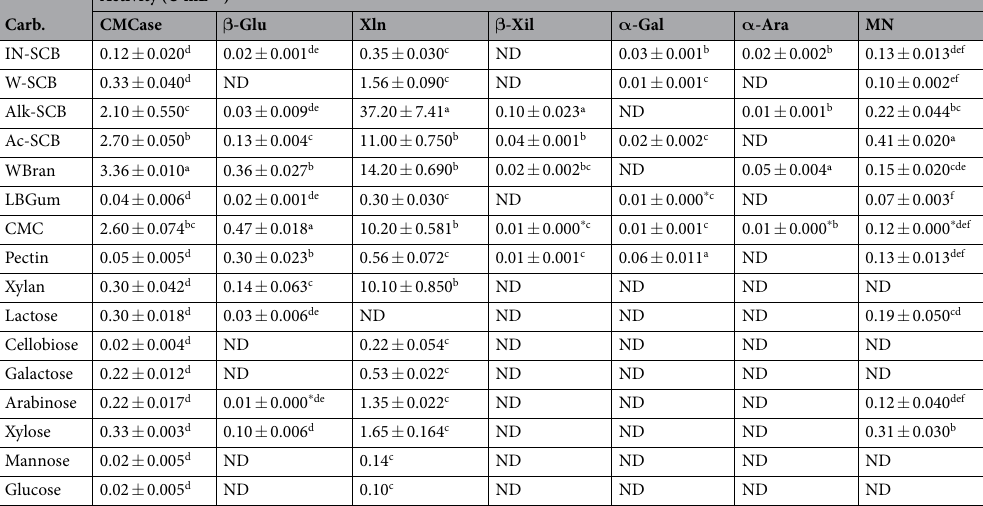
Arabinose 0.22 ± 0.017 d